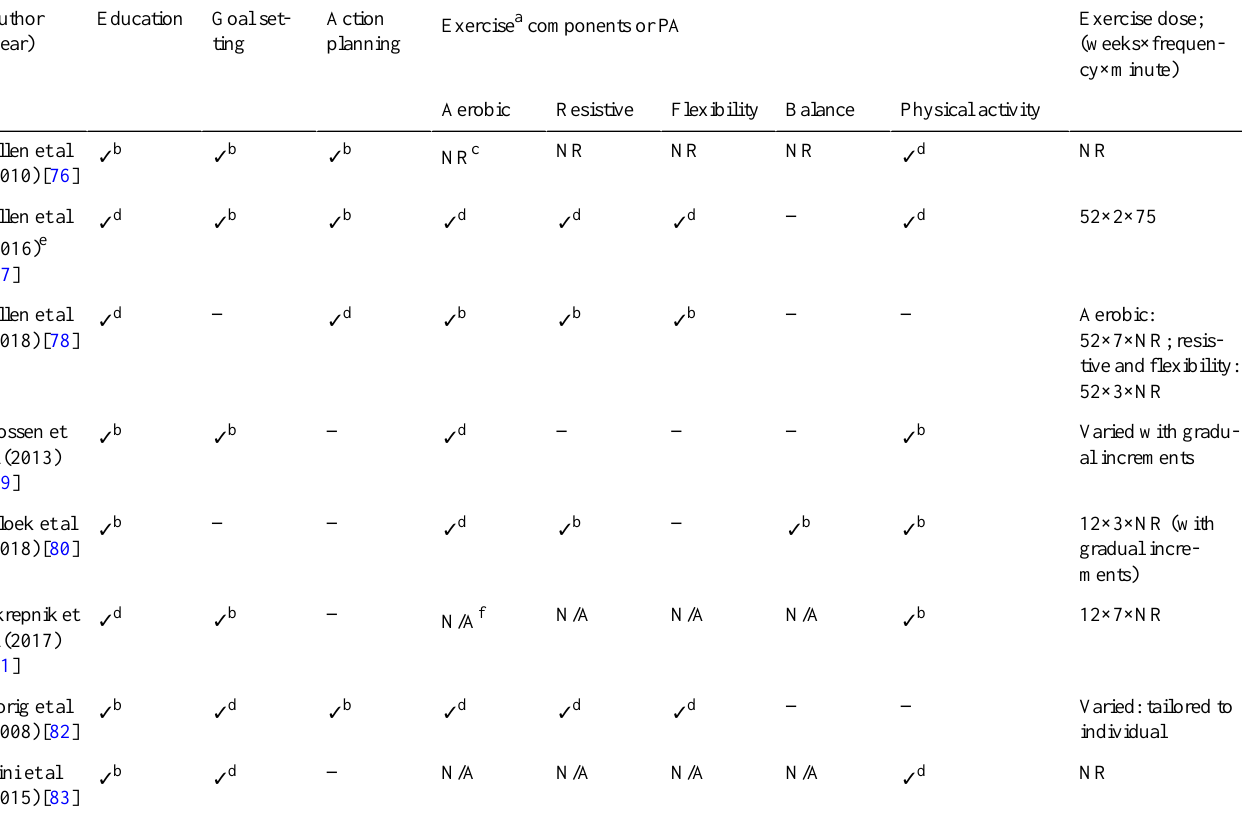
Table 4. Detailed self-management program components.